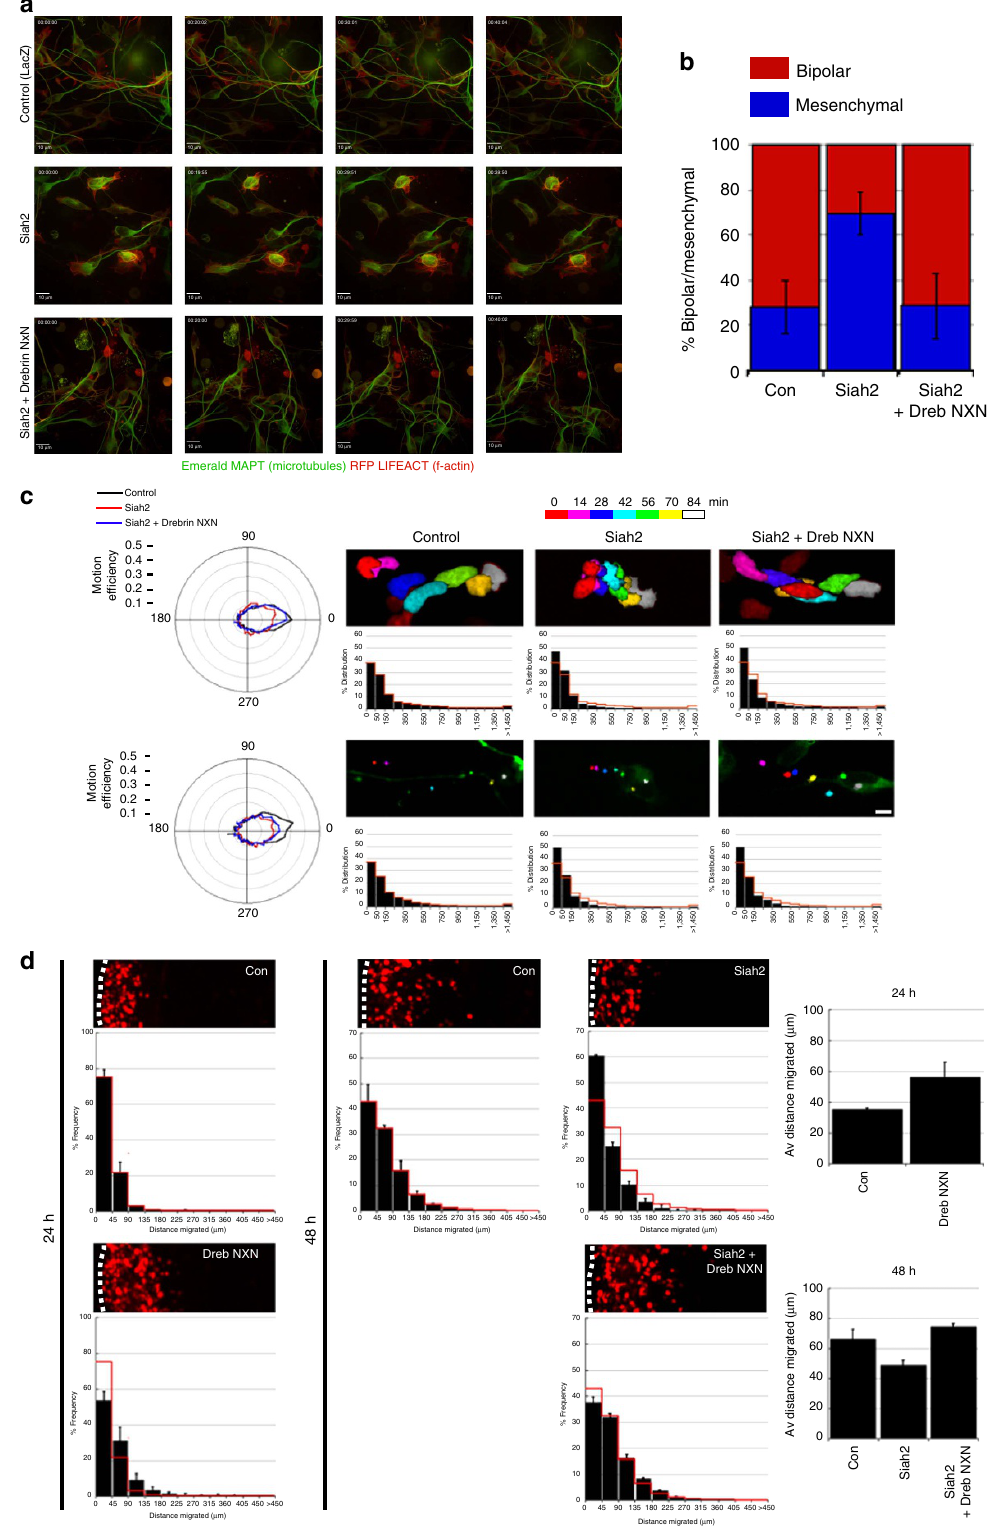
NATURE COMMUNICATIONS|8:14484|DOI: